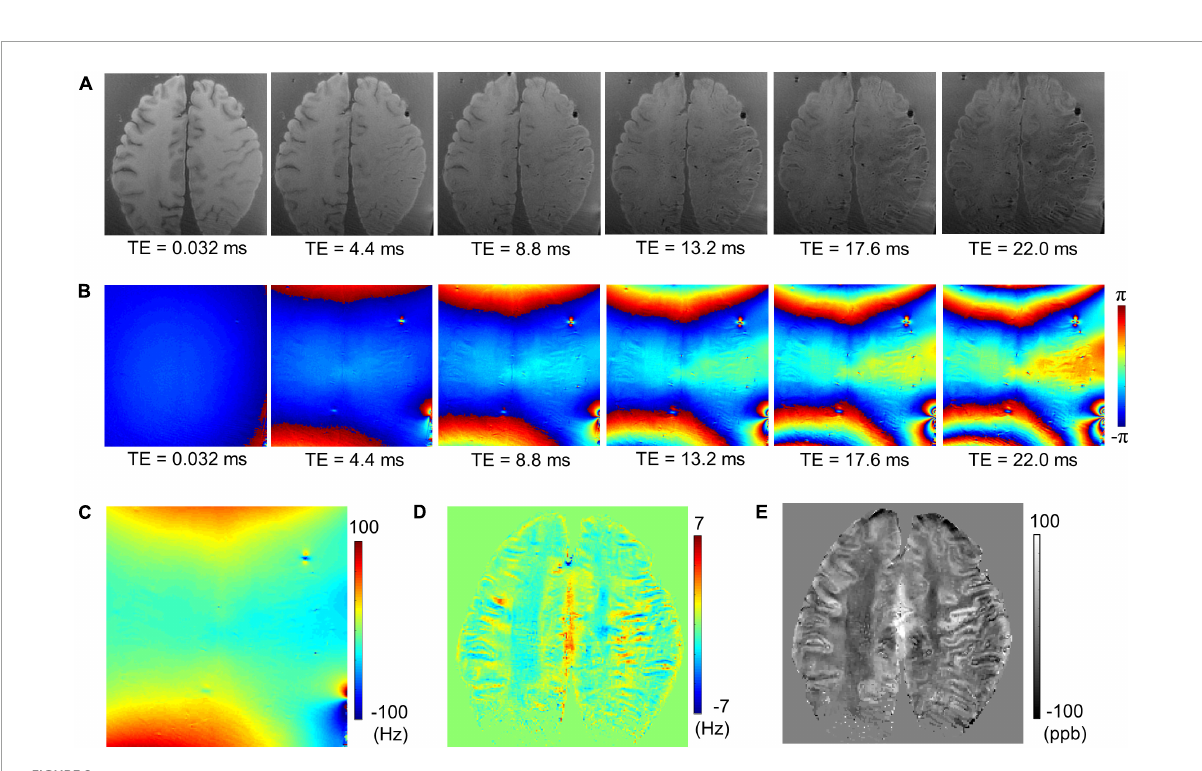
FIGURE2 Ultrashort echo time quantitative susceptibility mapping (UTE-QSM) with a cadaveric brain (82-year-old female donor). (A) Magnitude images, (B) phase images, (C) the total field map, (D) the local field map after background field removal, and (E) the resultant susceptibility